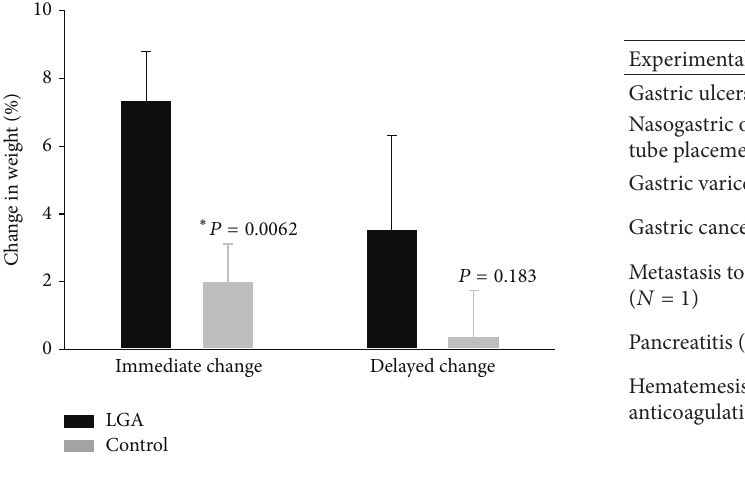
Figure 2: Bar graph comparing the change in weight between patients after LGA embolization (black bars) or embolization of another celiac trunk branch (gray bars). Patients lost significantly more weight after LGA embolization at the early time point ( 𝑃 = 0.006 ) but the difference in weight loss was not statistically significant at the delayed time point ( 𝑃 = 0.183 ).